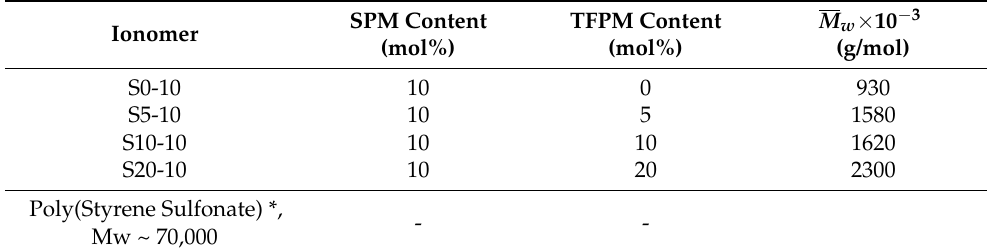
Figure 5. TEM images (50,000 × magnification) of ternary random ionomer (S0-10) aggregates ( A ) and quaternary random ionomer (S20-10) aggregates ( B ) in aqueous solution after dialysis. The initial ionomer concentration was 1 wt.%. The error bars in both images represent a 0.5 μ m scale. Table 2. Weight-averaged molecular weights ( M w ) of random ionomers from SLS measurements. Ionomer